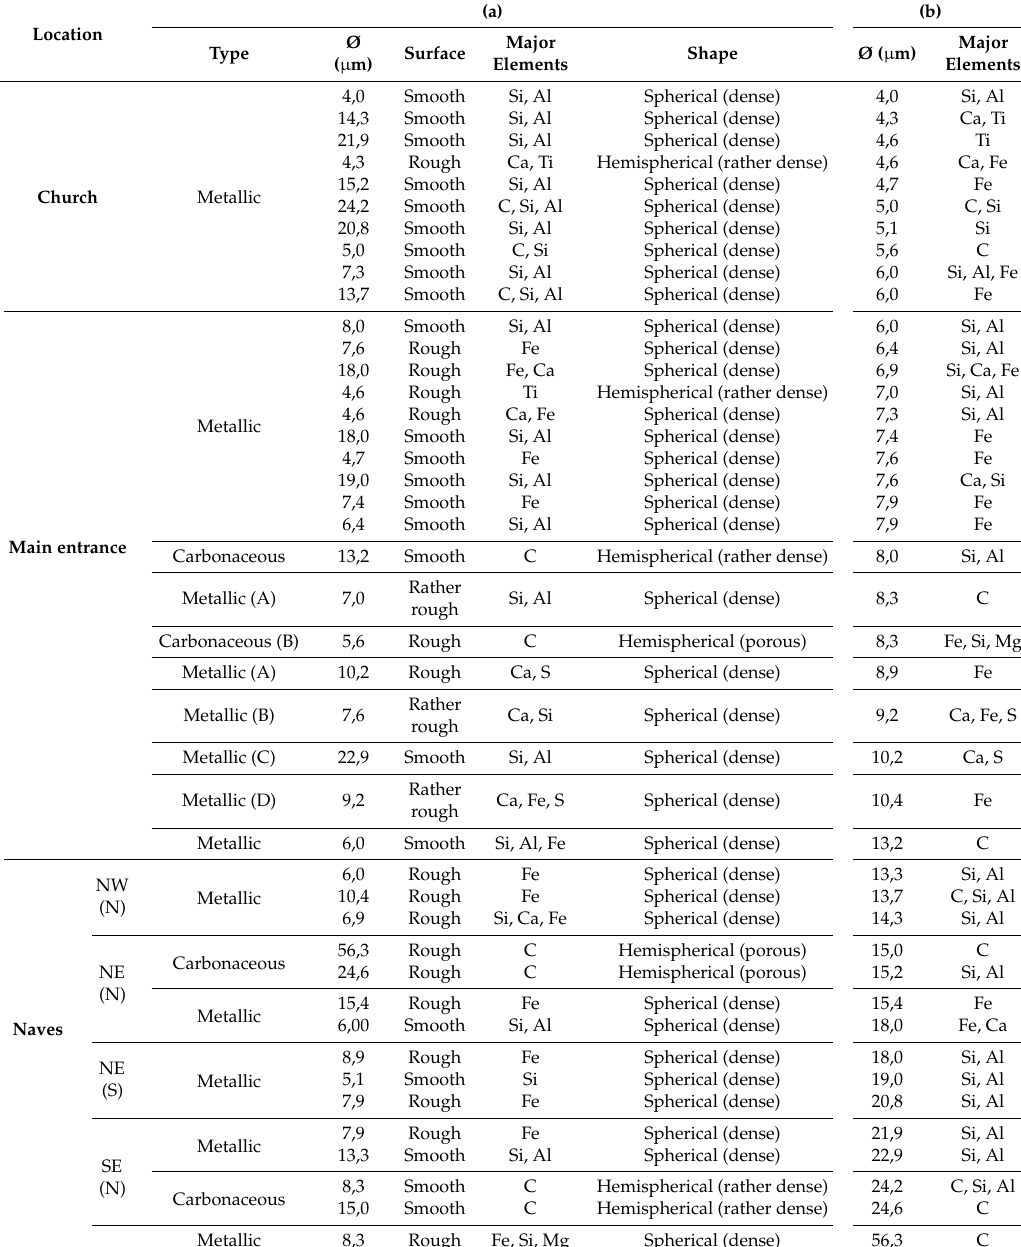
Table 2. Size, shape and composition of the spherical particles identified (a) and its ordering in accordance their size, along with their majority elements